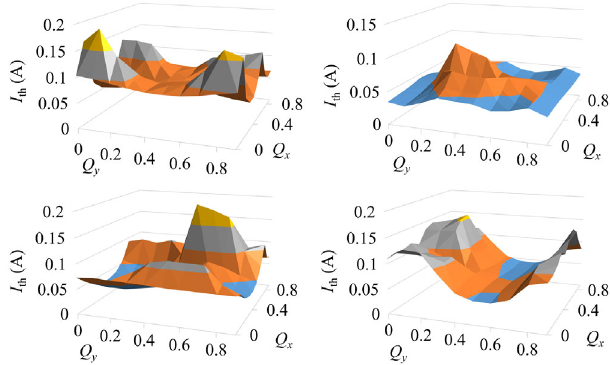
FIG. 10. Minimal threshold current for different modes in MESA. Five of the most dangerous dipole mode pairs are enclosed in a green box.